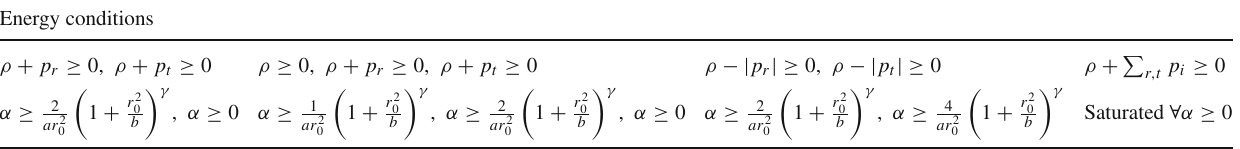
Fig. 7 The dominant energy condition along the radial and tangential directions for the model #1 against the dimensionless coordinate r / r 0 and different values mentioned in the Table 3, considering β = 0 . 45 ( km − 2 ) and the wormhole throat size r 0 = 1 Table 4 The general constraints on α , obtained from the energy conditions for the model #2, taking into account that the space parameter { γ, a , b } is positive defined